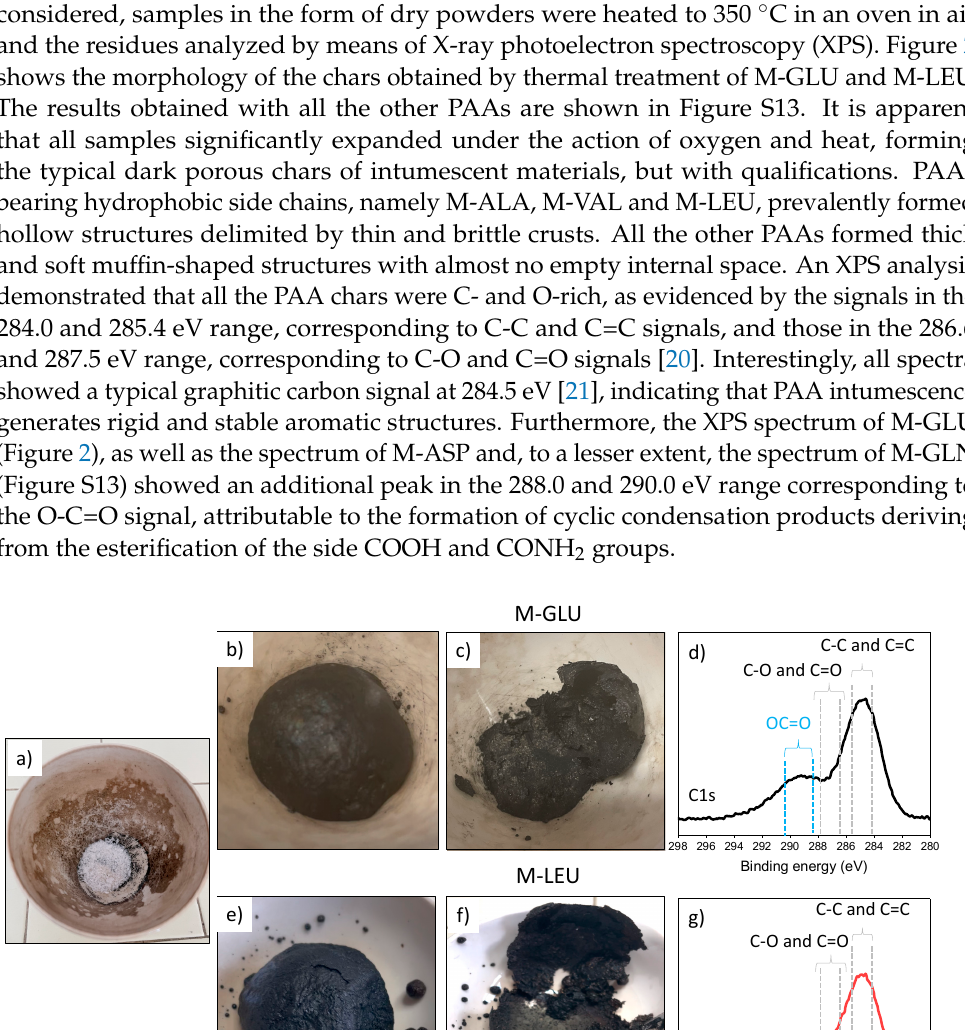
duration of 25 s, leaving 90%